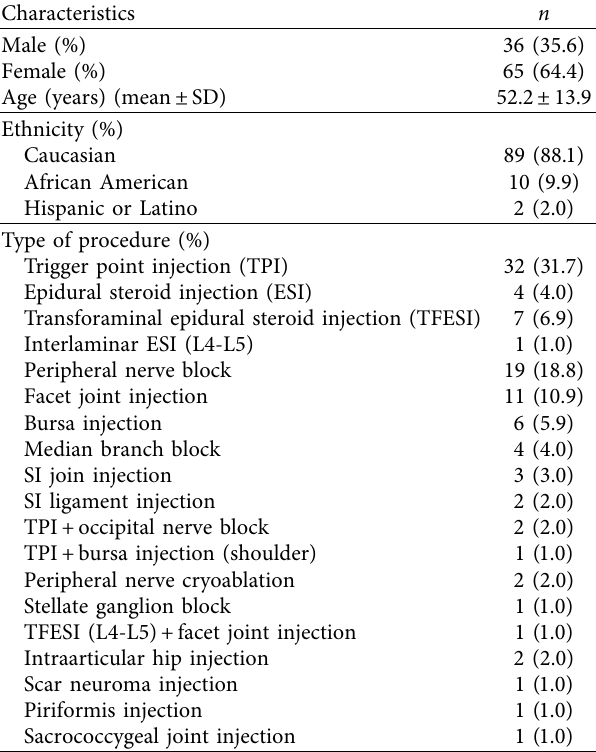
Table 2: Demographics and type of pain management procedure.